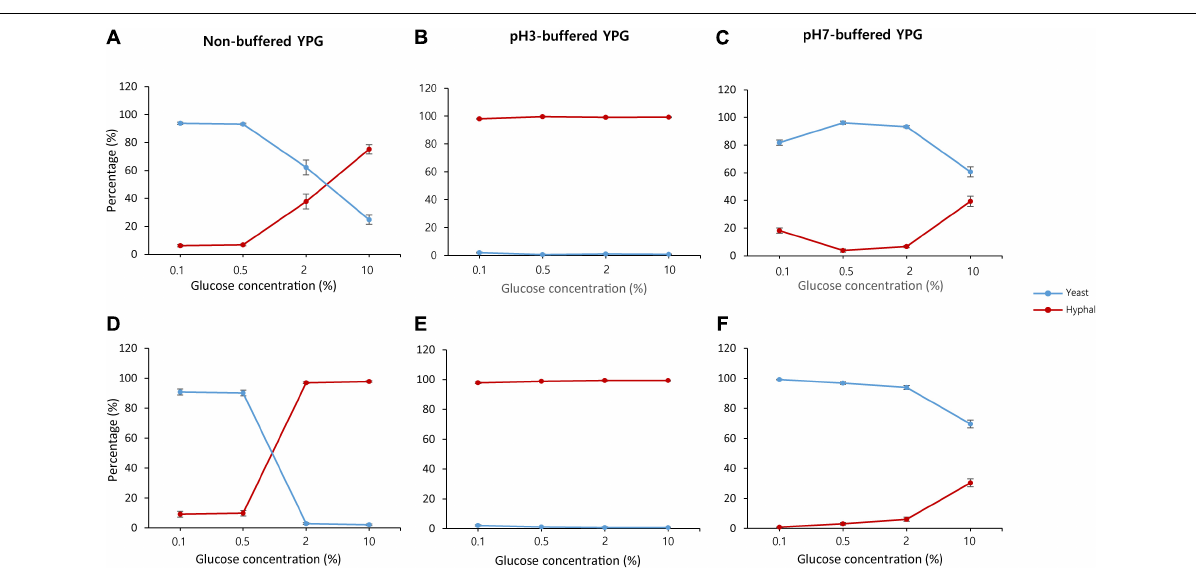
FIGURE 2 | Percentage of yeast and mycelium in Saccharomycopsis fibuligera . KPH12 strain (A–C) and KJJ81 interspecies hybrid strain (D–F) were grown in YPG broth supplemented with 0.1, 0.5, 2, and 10% glucose in non-buffered conditions (A,D) , pH 3-buffered conditions (B,E) , and pH 7-buffered conditions (C,F) . Blue, yeast percentage; and red, hyphae